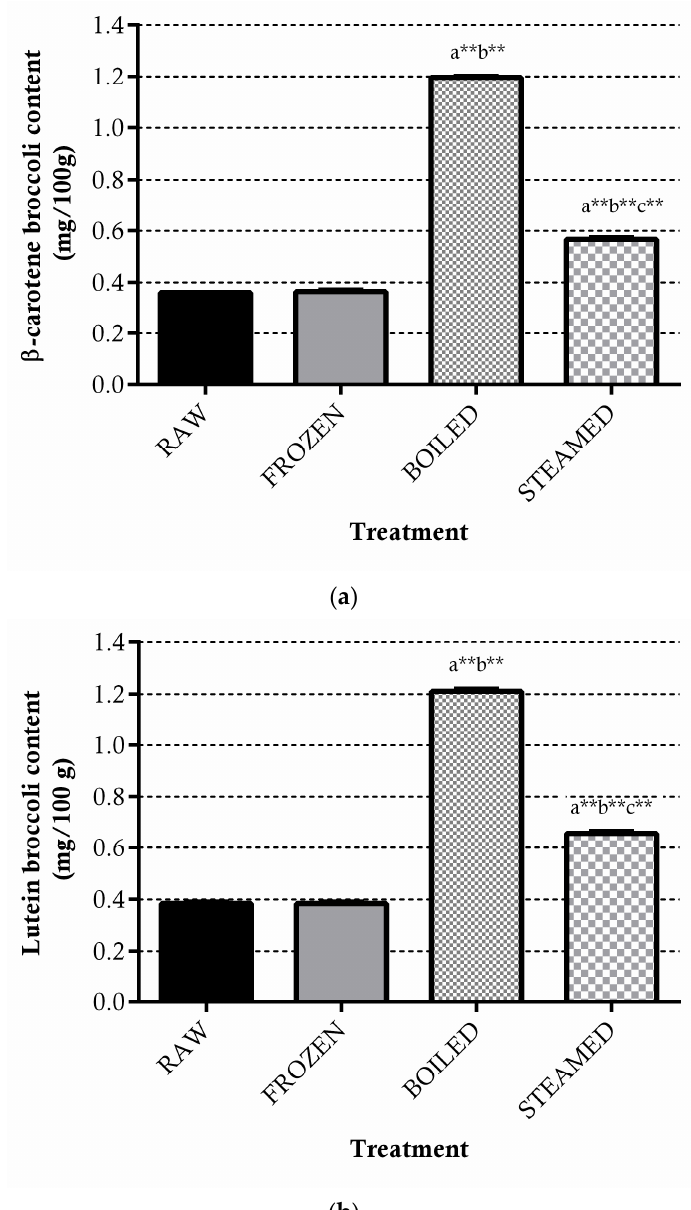
Figure 3. Total β -carotene ( a ) and lutein ( b ) levels in raw, frozen ( − 20 °C for 15 days) boiled and steamed broccoli. Data are expressed as mg/100 g of fresh vegetables ± SD of five cooking replicates. ** p < 0.01 vs. raw (a), frozen (b) and boiled (c).